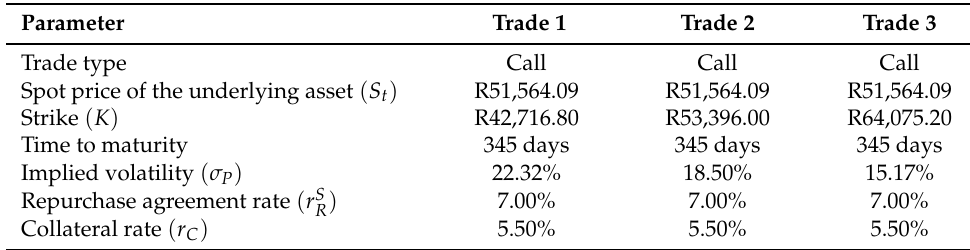
Table 9. Fully collateralized trade specifications.